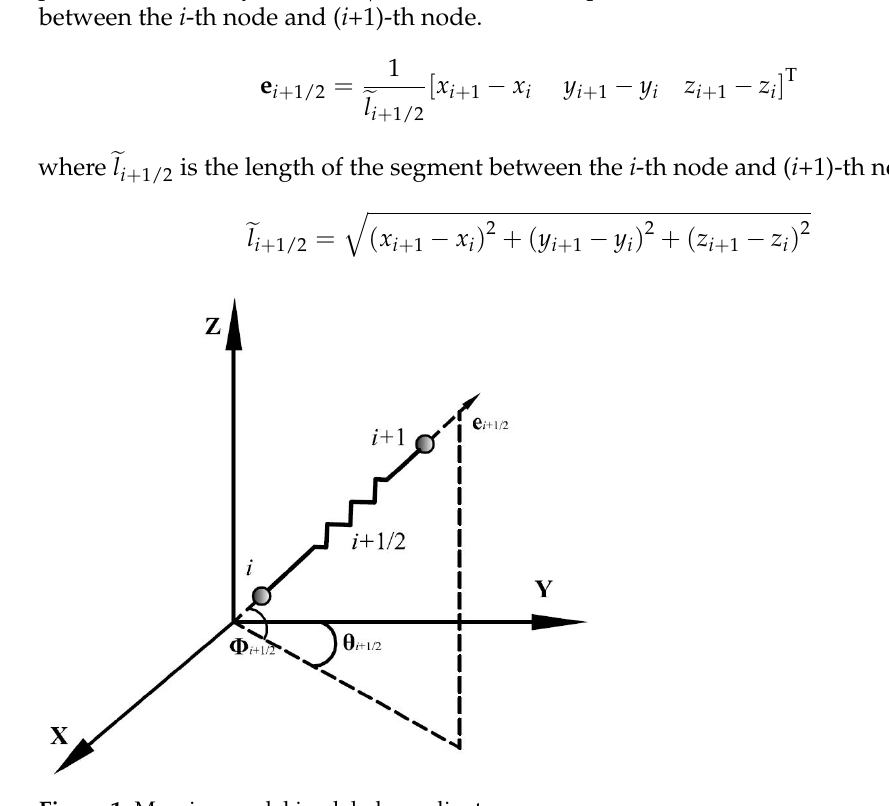
Figure 1. Mooring model in global